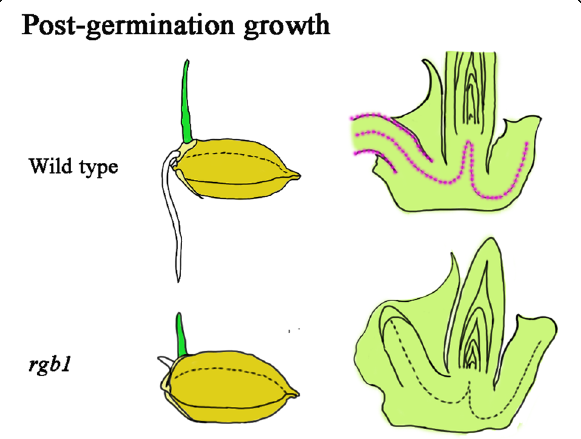
Fig. 7 Model of RGB1 function in early postgermination development in rice. RGB1 specifically functions in vascular tissue and epidermal cells (pink) in rice embryos during the early postembryogenic development stage. The development of the shoots, roots, and the embryo shoot- root axis is significantly suppressed in the rgb1 mutants and the rgb1 mutants are early postgermination